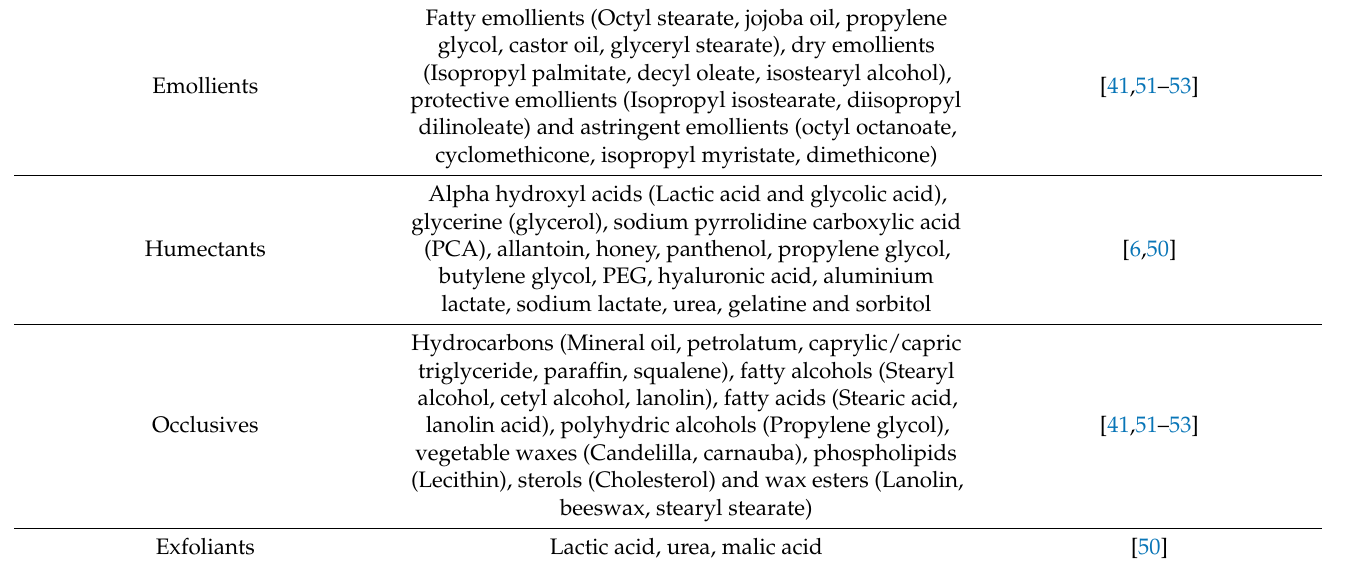
Table 1. Common active ingredients present in